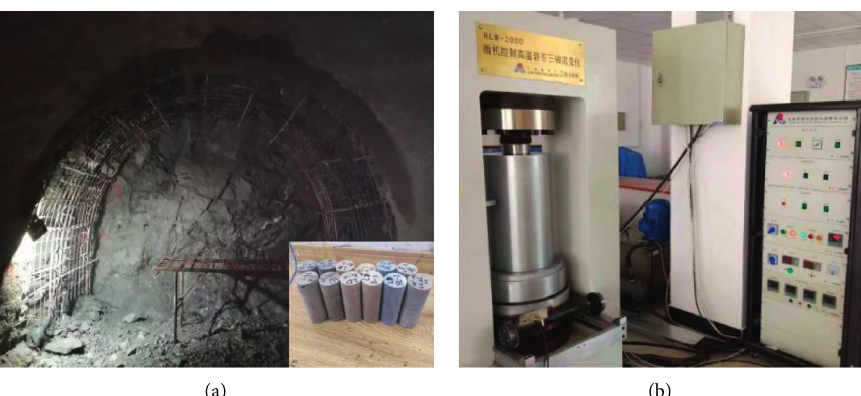
Figure 5: Experimental process of rock mass in the station. (a) Rock specimen collection and preparation. (b) Triaxial experimental instrument.